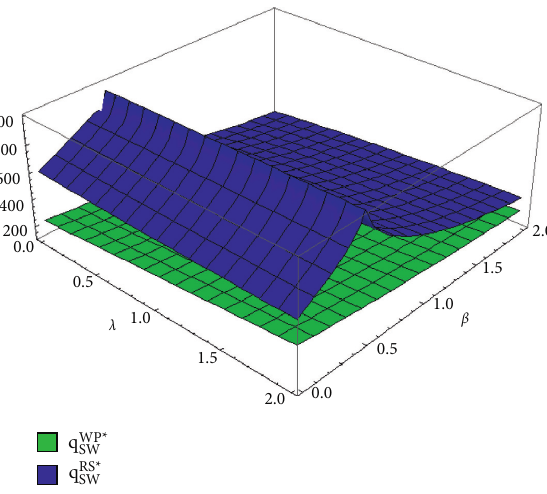
Figure 9: Effect of λ and β on order